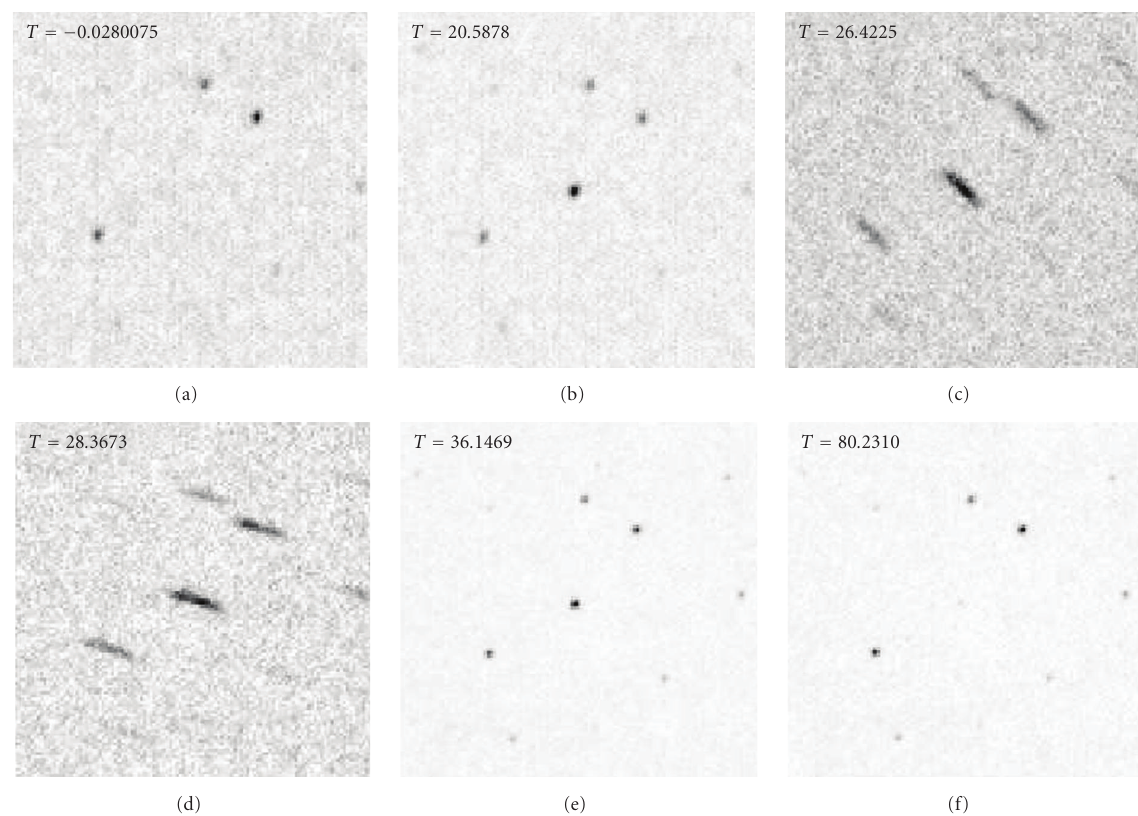
Figure 4: The development of prompt optical emission from GRB080319b as seen by TORTORA camera. Sums of 10 consecutive frames with 1.3s e ff ective exposures are shown for the gamma-ray trigger time ( T = 0s), the maximum brightness time during the first peak ( T = 20 . 5 s), two middle-part moments ( T = 26 . 4 s and T = 28 . 4 s), at the last peak ( T = 36s), and during early afterglow ( T = 80 s) stages. Image size is 2 . 5 × 2 . 5 degrees. The third and fourth images display deformed star profiles as during this time (since T + 24s till T + 31s) REM robotic telescope (which has TORTORA camera mounted on top) repointed after receiving the burst information from Swift. Initially, burst position was on the edge of field of view, as a result of repointing it moved to the center of field of view, which resulted in better data